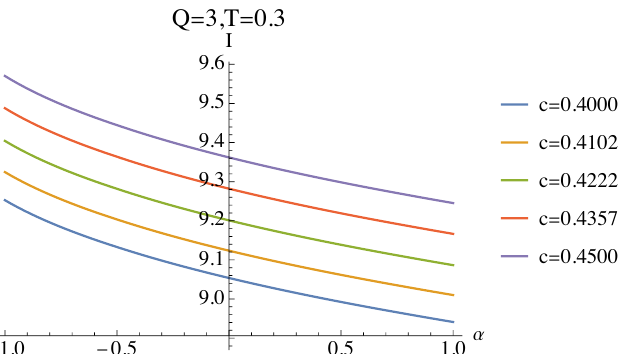
Figure 8 . The MI vs α in different configurations ( a, b, c ) by choosing a = 0 . 6 , b = 0 . 1 with different value of c . The MI decreses with the increasing α . However, MI increases with the increasing of c. This means that MI increases when the configuration tends to be symmetrical.